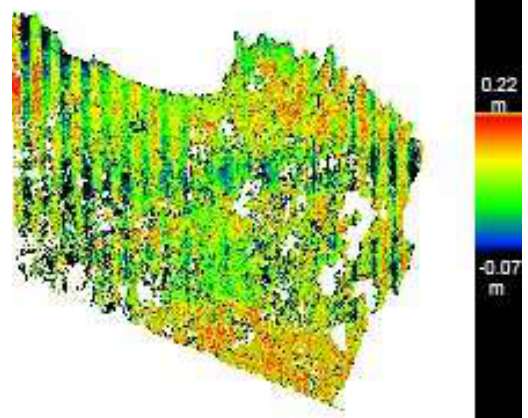
Figure 4. Averaged y-parallaxes of a WV-2 stereo model